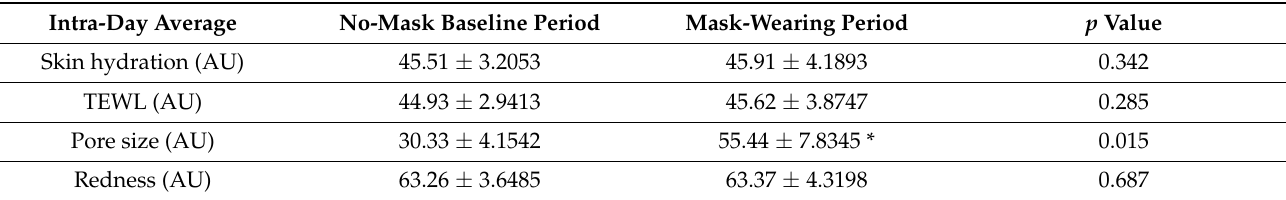
Table 1. Intra-day averages of facial skin variables.